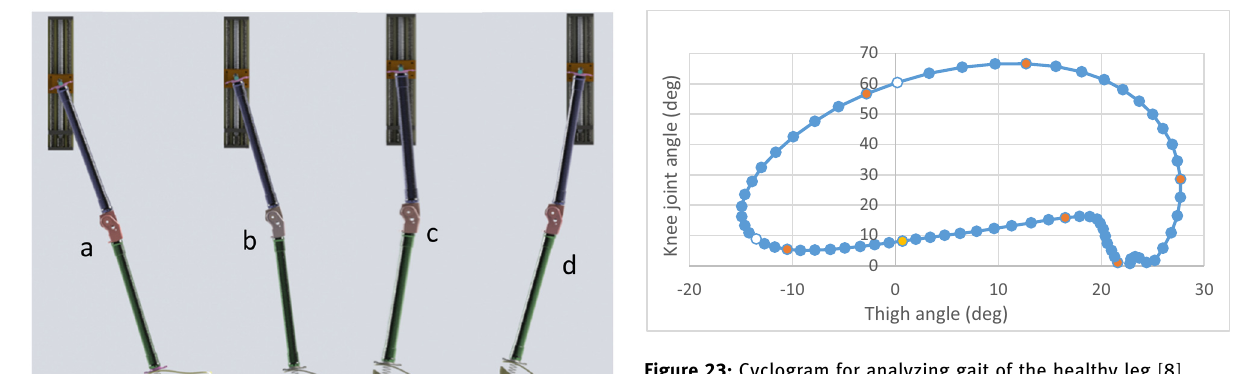
Figure 23: Cyclogram for analyzing gait of the healthy leg [ 8 ] .